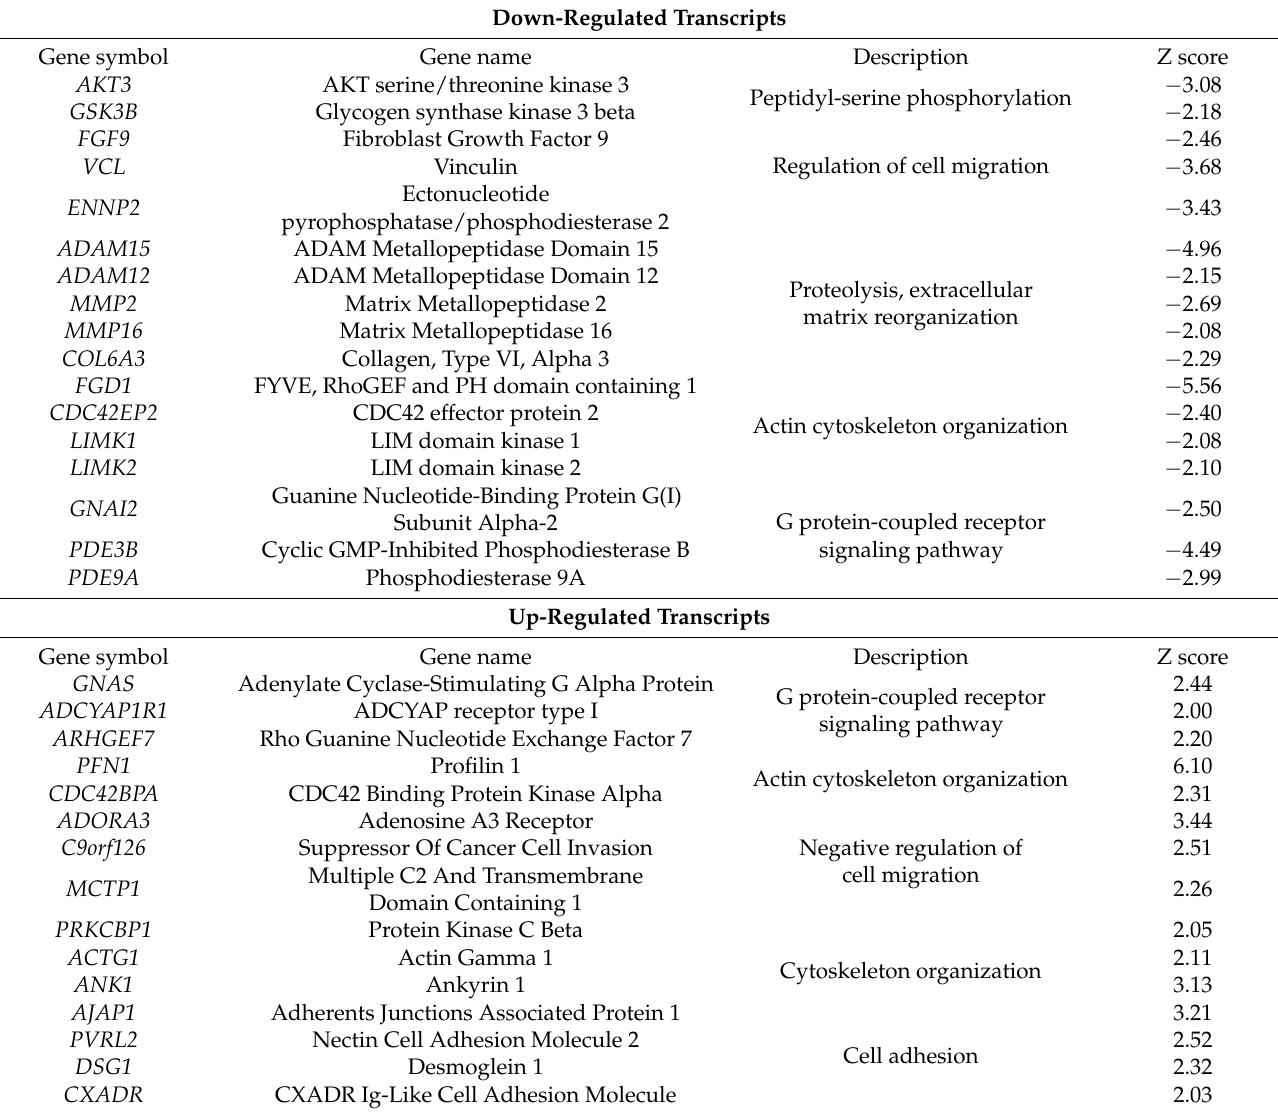
Table 1. Transcripts regulated by A2BR stimulation with 10 mM of BAY for 24